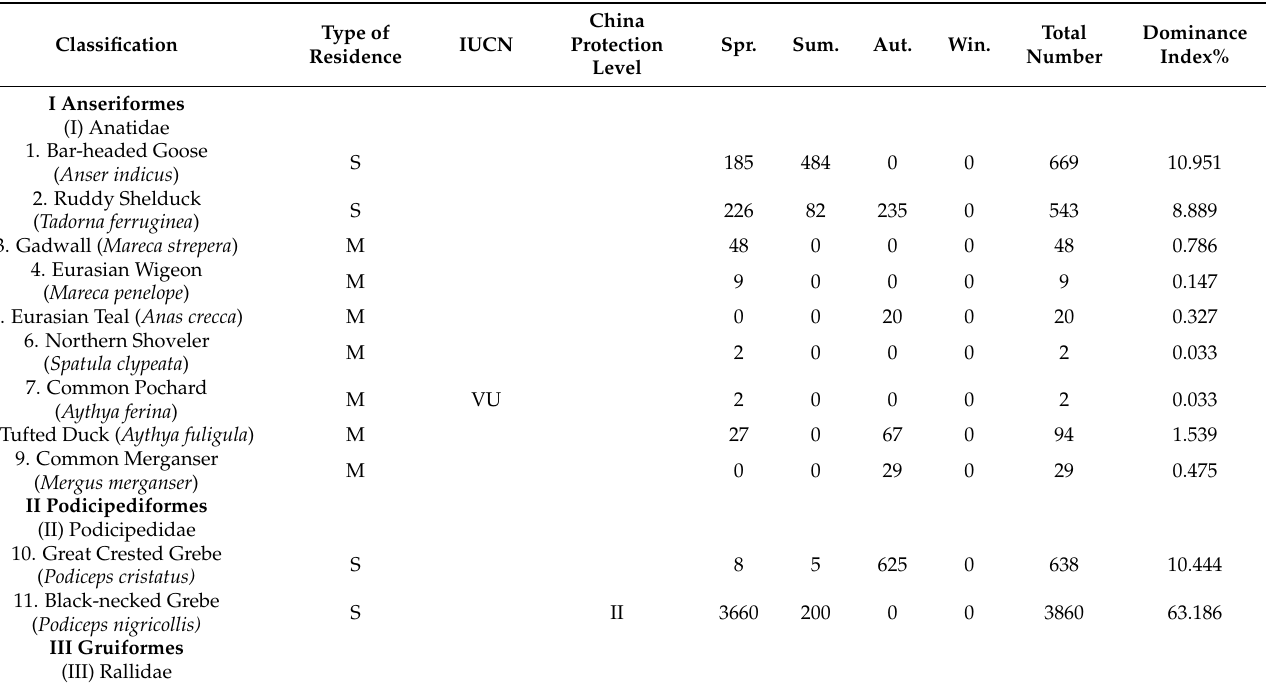
Table A1. List of birds of Mangcuo